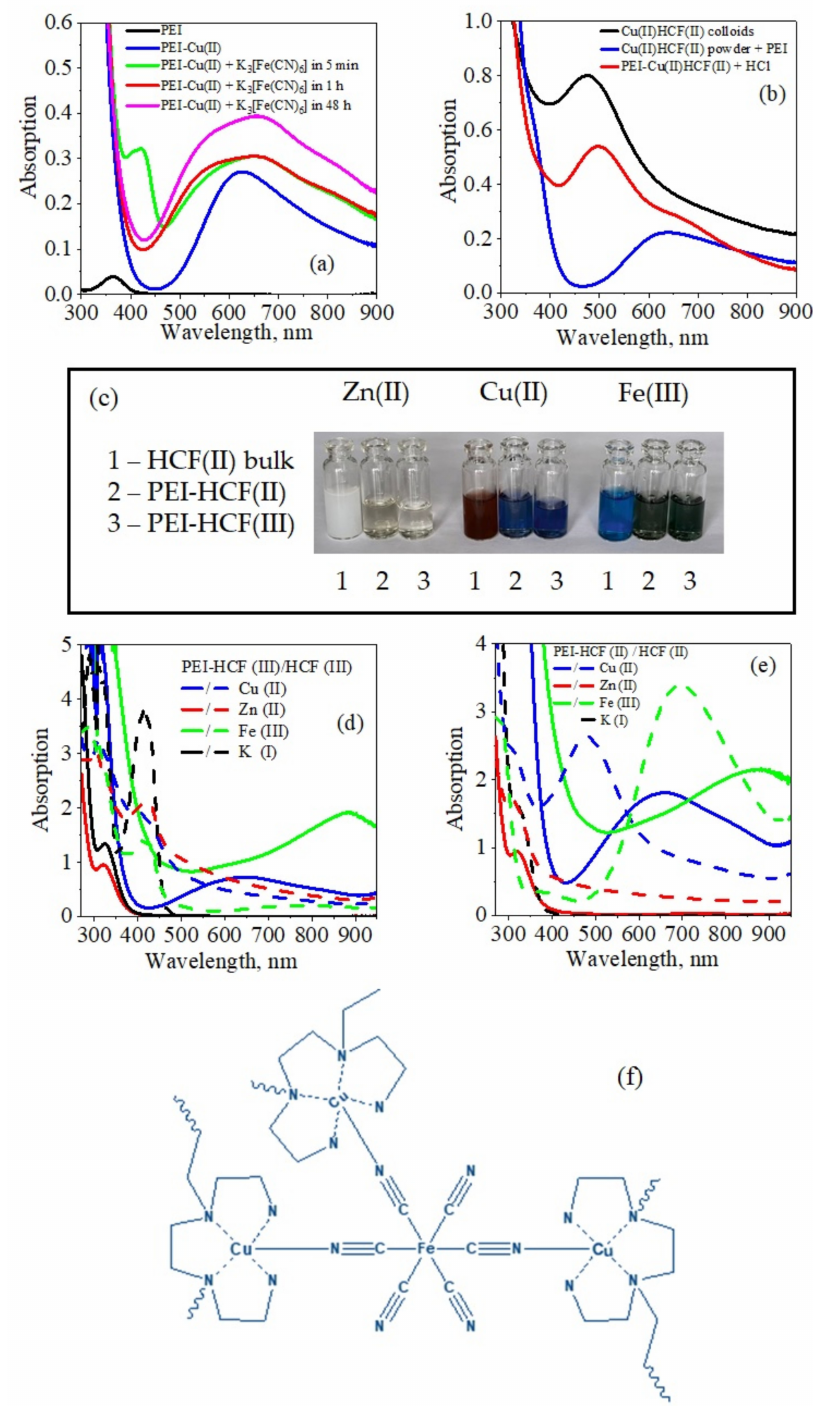
Figure 6. Optical properties of colloidal hexacyanoferrates (HCF) and related PEI–HCF hybrids: ( a ) evolution of electronic spectra of PEI–Cu(II)HCF(III) in solution; ( b ) reversible changes of optical properties after dissolution of crystalline powder of Cu(II)HCF(II) in PEI solution and after 4 M HCl addition to the solution of PEI–Cu(II)HCF(II) cyano-bridged complex; ( c ) photo of freshly precipitated HCFs(II) colloids and cyano-bridged complexes PEI–HCF(II) and (III) in solution; electronic spectra of colloidal hexacyanoferrates (HCF) and related cyano-bridged complexes obtained in solution using K 4 [Fe II (CN) 6 ] ( d ) and K 3 [Fe III (CN) 6 ] ( e ) as precursors. Hypothetical structure of PEI–Cu(II)HCF(II) cyano-bridged complex ( f